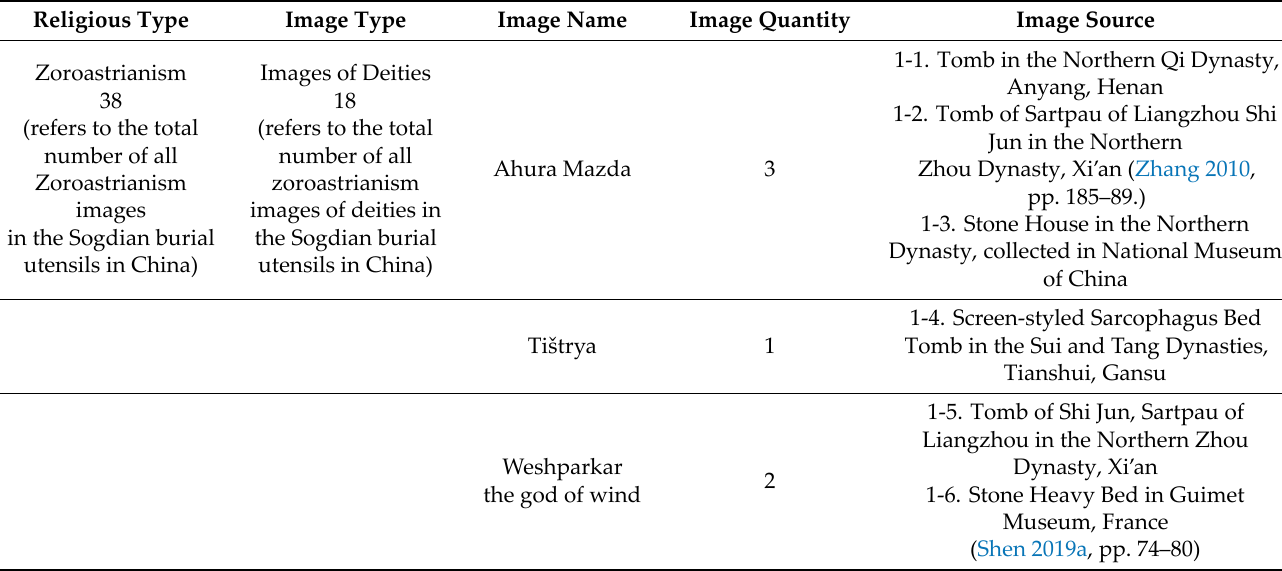
Table 4. Religious Images Table of Sogdian Sarcophagi in